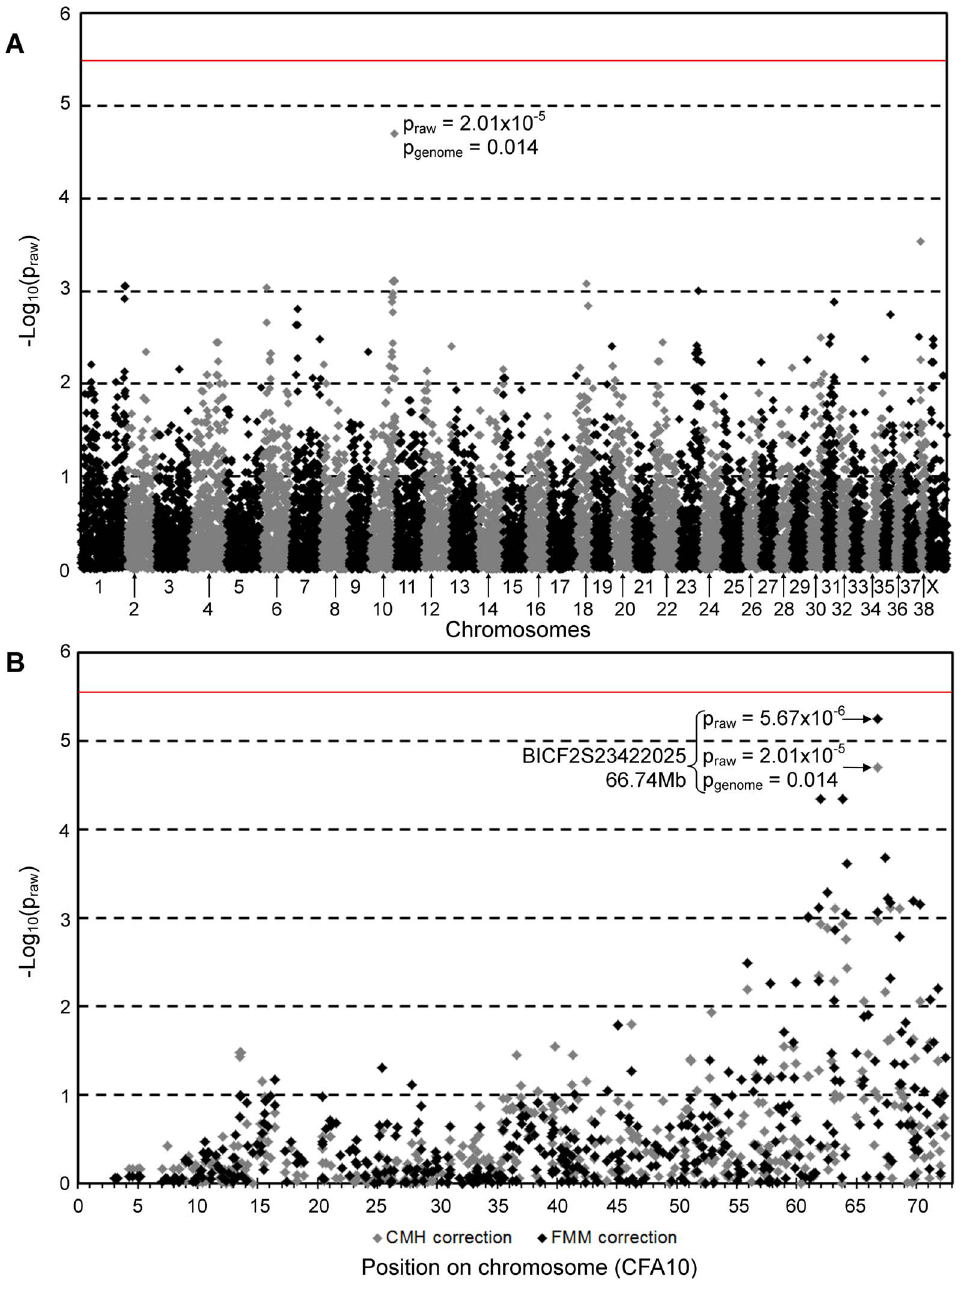
Figure 1. Genome-wide association mapping of PRA in Tibetan Spaniels. -Log 10 of p-values after correction for population stratification. The red lines indicate the Bonferroni-corrected 5% significance level based on 15,674 SNPs. A) The CMH meta-analysis approach shows the strongest signal on CFA10 (p raw =2.01 6 10 2 5 , P genome =0.014). B) The signal spans a region of 5.37 Mb from 62 to 67.37 Mb on CFA10.